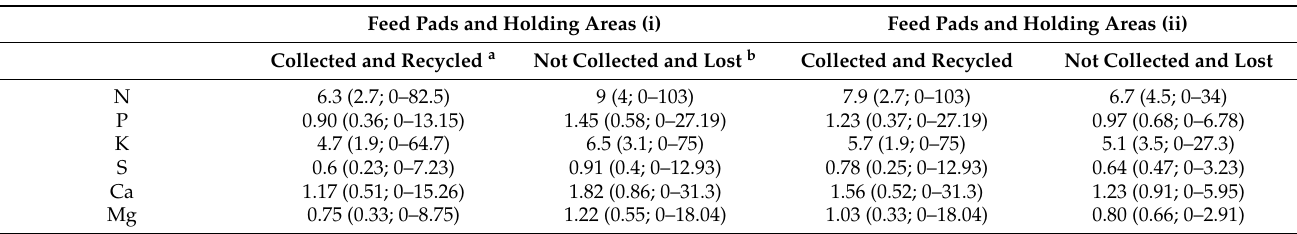
Table 7. Daily mean (median; min-max) nutrients (kg) in the collected and recycled pool, and in the not collected and lost pool for the seventeen farms (i) where nutrients deposited in excreta to feed pads and holding areas were not collected, or (ii) if these deposited nutrients were